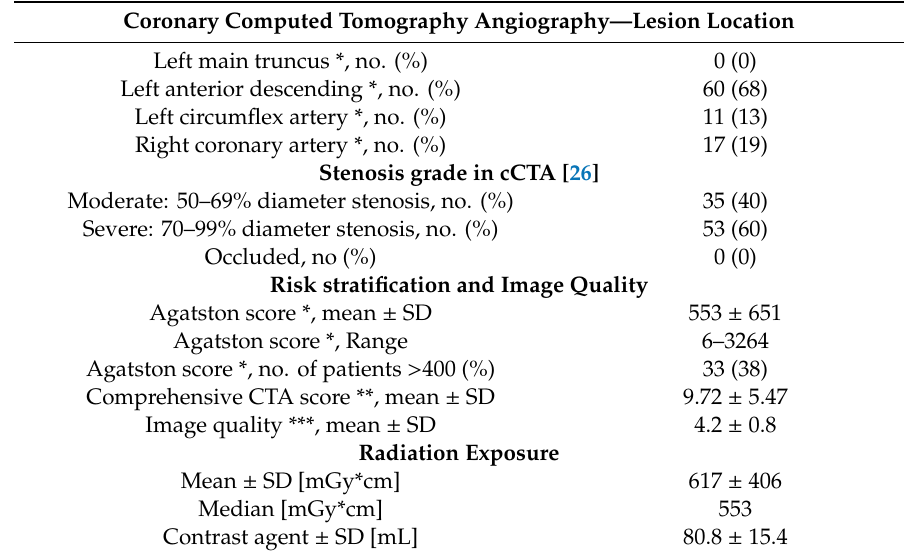
Table 3. Findings of cCTA ( n = 88).